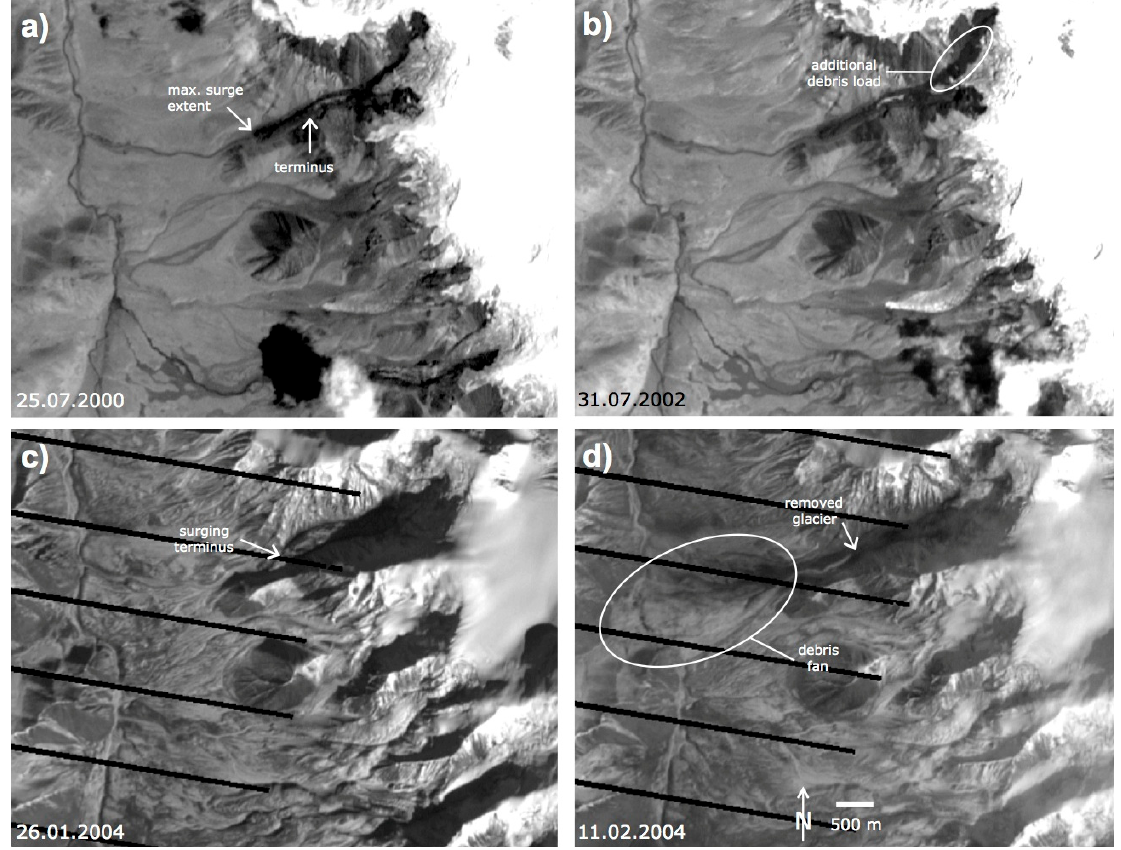
Figure 5. Landsat ETM+ pan images from ( a ) 25 July 2000, ( b ) 31 July 2002, ( c ) 26 January 2004, and ( d ) 11 February 2004 showing in ( a ) the active terminus in 2000 compared to the maximum surge extent, ( b ) the loading with debris by 2002, in ( c ) the maximum surge extent in 2004 before the collapse, and in ( d ) the debris fan after the collapse. Image source: earthexplorer.usgs.gov.